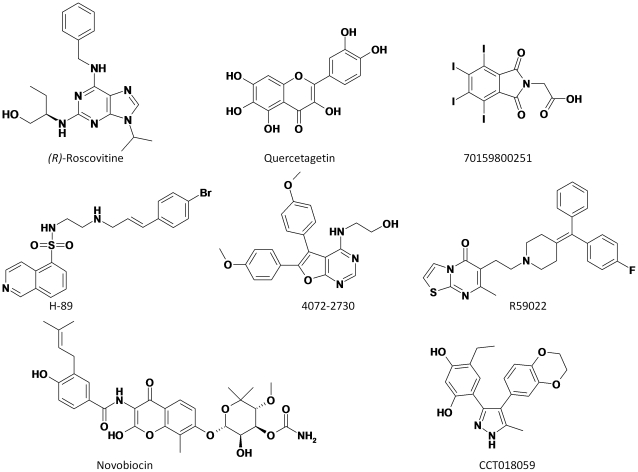
Chemical structures of compounds tested for binding to bovine synapsin I.
(R)-Roscovitin (CDK2 inhibitor), Quercetagetin (Pim-1 kinase inhibitor), 7015980251 (Casein kinase II inhibitor), H-89 (protein kinase A inhibitor), 4072–2730 (Protein kinase Chk1 inhibitor), R59022 (diacylglycerolkinase inhibitor), Novobiocin (DNA topoisomerase II inhibitor), and CCT018159 (HSP-90 alpha inhibitor).